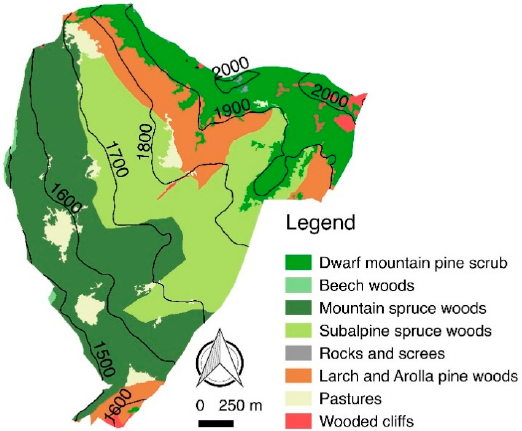
Figure 6. Distribution of land cover types in the Scanuppia Natura 2000 site. The altitudinal distribution of capercaillie in 2011, currently centered at 1620 to 1750 m a.s.l., is closer than in 2001 to the dwarf mountain pine scrub, which is unsuitable to capercaillie (source: Provincia Autonoma di Trento, Servizio Sistemazione Montana, 2001).